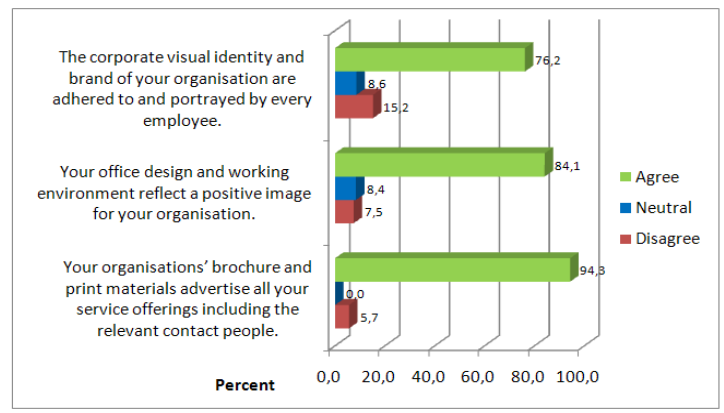
Fig. 8. Respondent scores: physical evidence